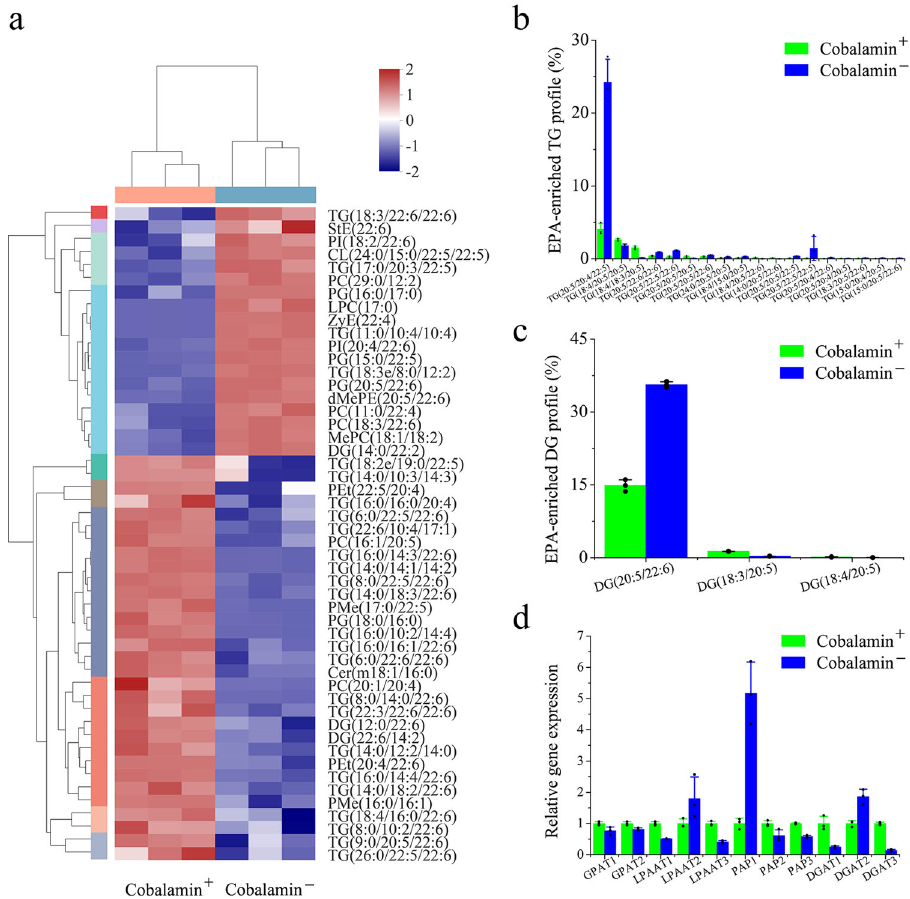
Fig. 5 Differences in lipid compound composition in Schizochytrium sp. under MetE-like activation. a Lipid compounds cluster analysis plot. The colors in the fi gure represent the relative expression levels of lipid compounds in this group of samples, the left side is the dendrogram of lipid compound clustering, and the right side is the name of the lipid compounds. b , c EPA-enriched TG pro fi le ( b ) and EPA-enriched DG pro fi le ( c ) in Schizochytrium sp.(60 h). d Comparison of fatty acid storage related genes transcript level between cobalamin + and cobalamin − of Schizochytrium sp. (60 h).